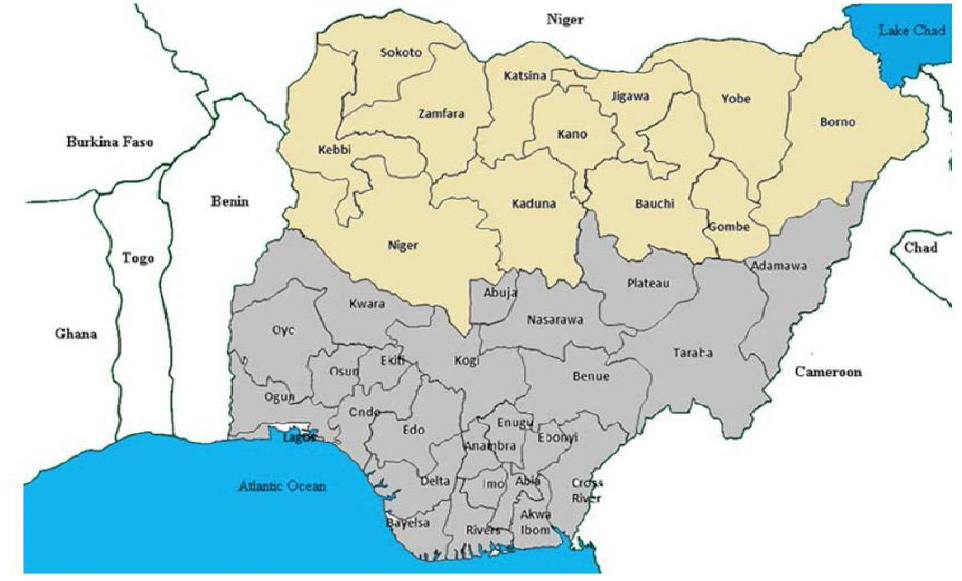
Figure 1: The map of Nigeria with Northern and Southern Regions (Source: Onyemaechi 2020) Terrorist incidents with large numbers of casualties remained uncommon in Western Europe in 2019. Nine terrorist acts out of 191 resulted in at least four wounded or killed individuals (Global Terrorist Group 2020). In the United States, there were 64 terrorist acts in 2019, with 51 people killed. A wide range of ideological influences still characterizes terrorism in the United States, some of which are complicated and ambiguous and rarely linked to formal, recognized groups. In the United States, 286 individuals were murdered in terrorist acts between 2015 and 2019 (excluding assailants). Almost all of the victims (95 percent) were killed in gun- related accidents. During this period, firearms were used in 27% of terrorist acts in the United States (Mandhana, Taylor, and Shah